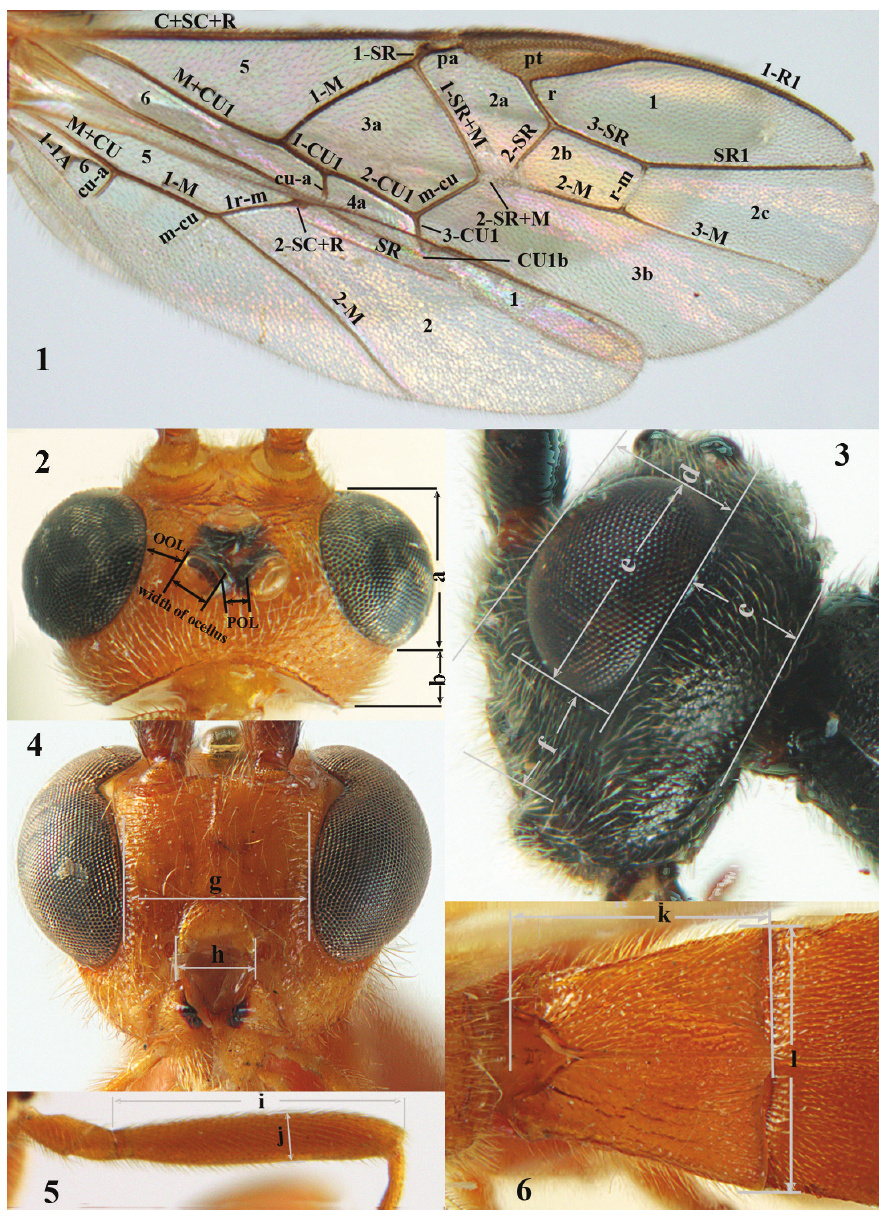
Figures 1–6. Terminology and measurements used in this paper. 1 wing venation: pa = parastigma, pt = pterostigma, 1 = marginal cell, 2a, b, c = first, second and third submarginal cell, respectively, 3a, b = first and second discal cell, respectively, 4a = first subdiscal cell, 5 = basal cell, 6 = subbasal cell 2 head dorsal: a = length of eye, b = length of temple 3 head lateral: c = width of temple, d = width of eye, e = height of eye, f = width of malar space (measured as actual true distance in its own plane) 4 head anterior: g = width of face, h = width of hypoclypeal depression 5 fore femur lateral: i = length, j = width 6 first metasomal tergite dorsal: k = length of tergite (measured from adductor), l = apical width of